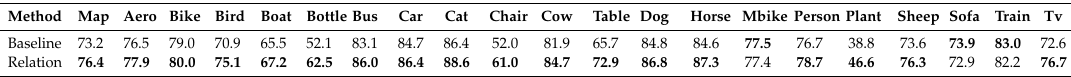
Table 6. Ablation study on MS COCO 2014 minival. All methods are trained on MS COCO train set. Baseline: Faster R-CNN trained. Scene: only using scene information. The bold characters represent the best result for each column. Table 7. Ablation study on PASCAL VOC 2007 test. All methods are trained on PASCAL VOC 2007trainval + 2012trainval. Baseline: Faster R-CNN. Relation: only using object-object relationships. The bold characters represent the best result for each column.